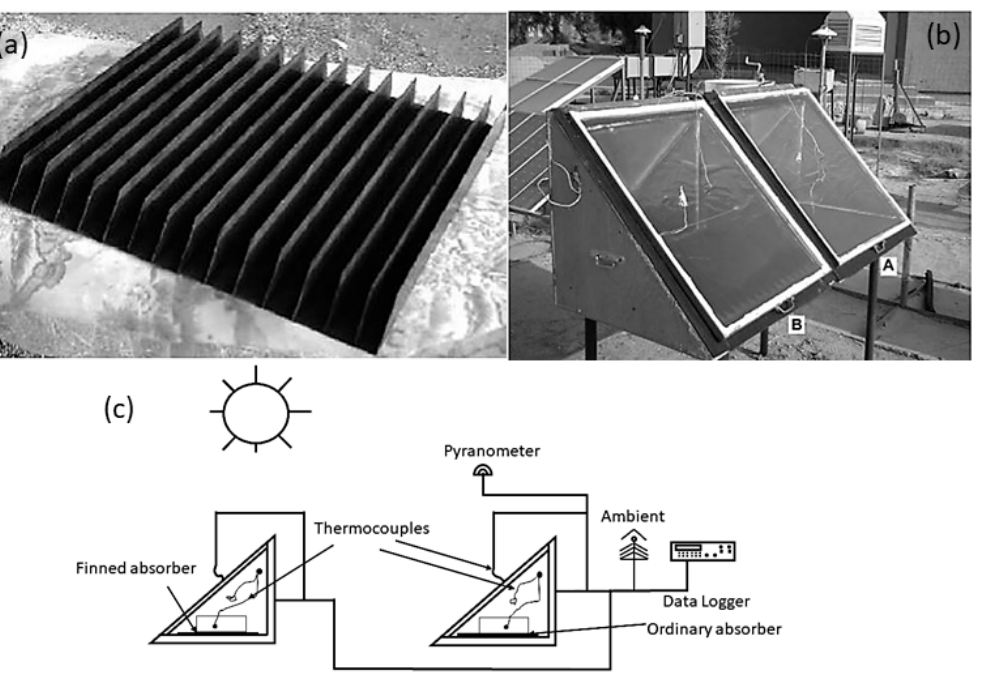
Figure 7. ( a ) Fins of the base plate of solar cooker; ( b ) Actual experiment set; ( c ) Schematic diagram of experiment. Reprinted/adapted with permission from Ref. [16], 2010, Elsevier.